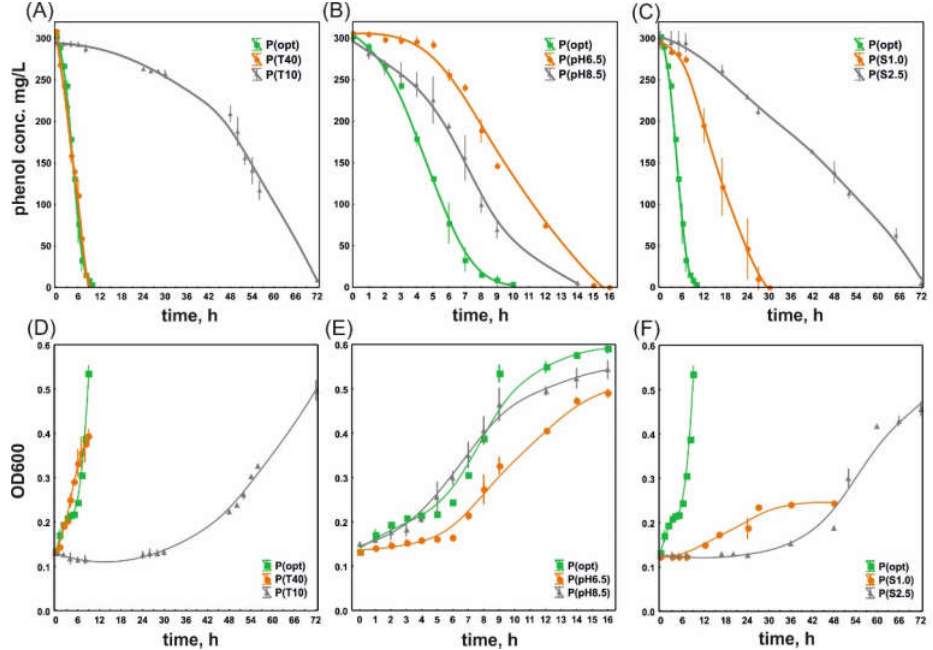
Figure 3. Phenol degradation rates ( A – C ) and the growth curves of P. moorei KB4 ( D – F ) under different culture conditions. Abbreviations: P—phenol (300 mg/L); opt—optimal conditions, T—temperature, pH—pH value; S—salinity. Table 1. The degradation rate constant ( k ), disappearance time of 50% of phenol (DT 50 ), and disap- pearance rate ( V ) of phenol in batch cultures of S. maltophilia KB2 and P. moorei KB4 under different culture conditions.